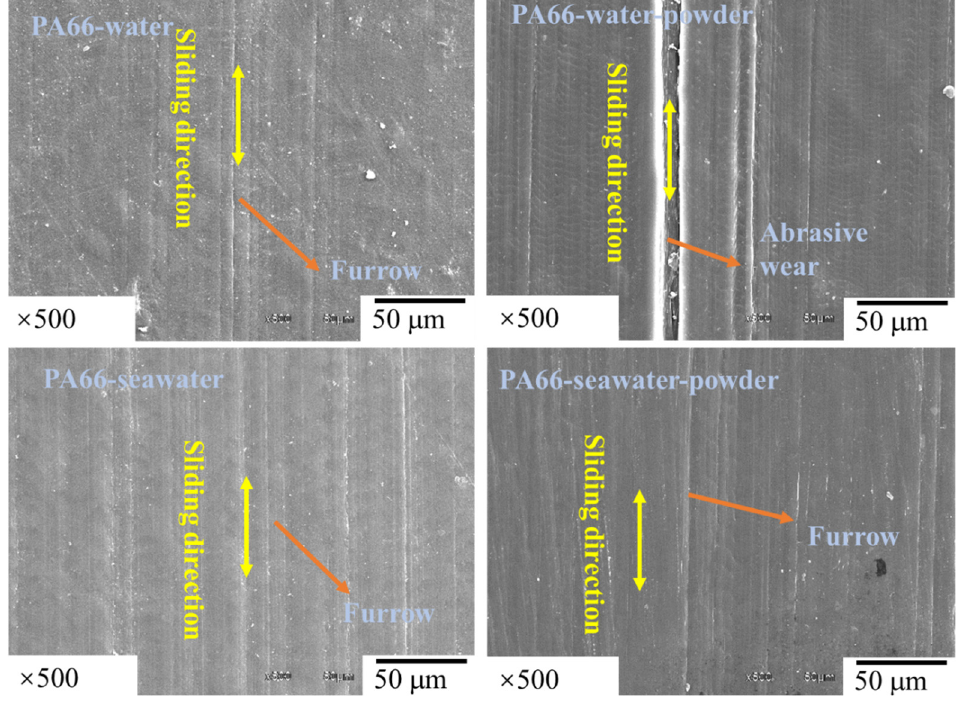
Figure 10. Micrograph images captured using white-light interference three-dimensional profilometer. Table 6. The roughness of PA66 pins surface.